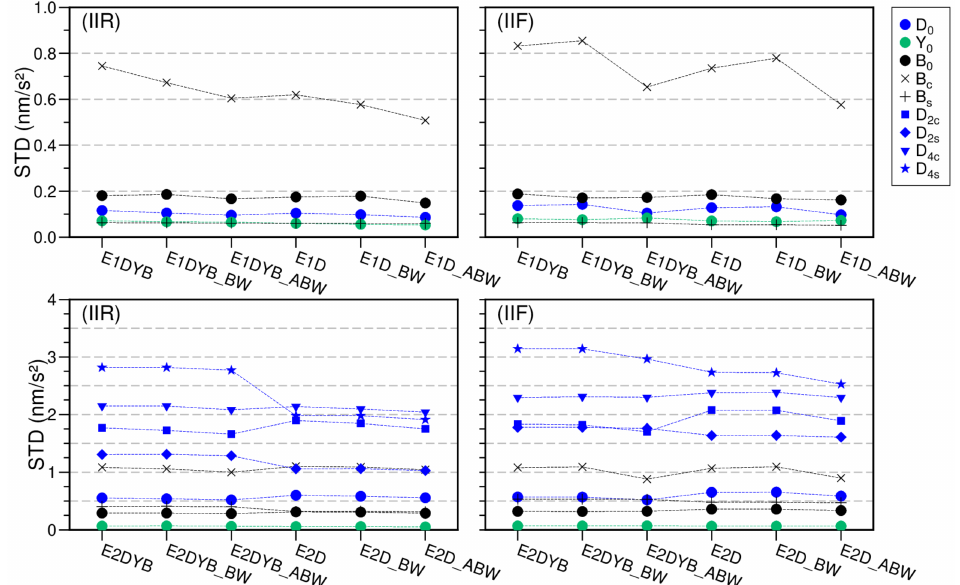
Figure 6. Standard deviation (STD) of SRP coefficient time series for eclipsing satellites in the 12 solutions. Upper panels: ECOM1 empirical SRP modeling; lower panels: ECOM2 empirical SRP modeling; left panels: GPS BLOCK IIR satellites; right panels: GPS BLOCK IIF satellites. Note the different y -axis scales between the upper and lower